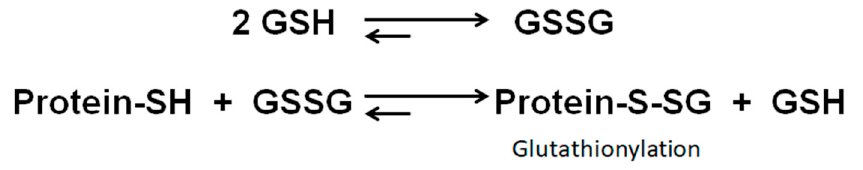
Figure 10. An imbalance between reduced glutathione (GSH) and oxidized glutathione disulfide (GSSG) can induce the formation of greater glutathionylation of proteins.